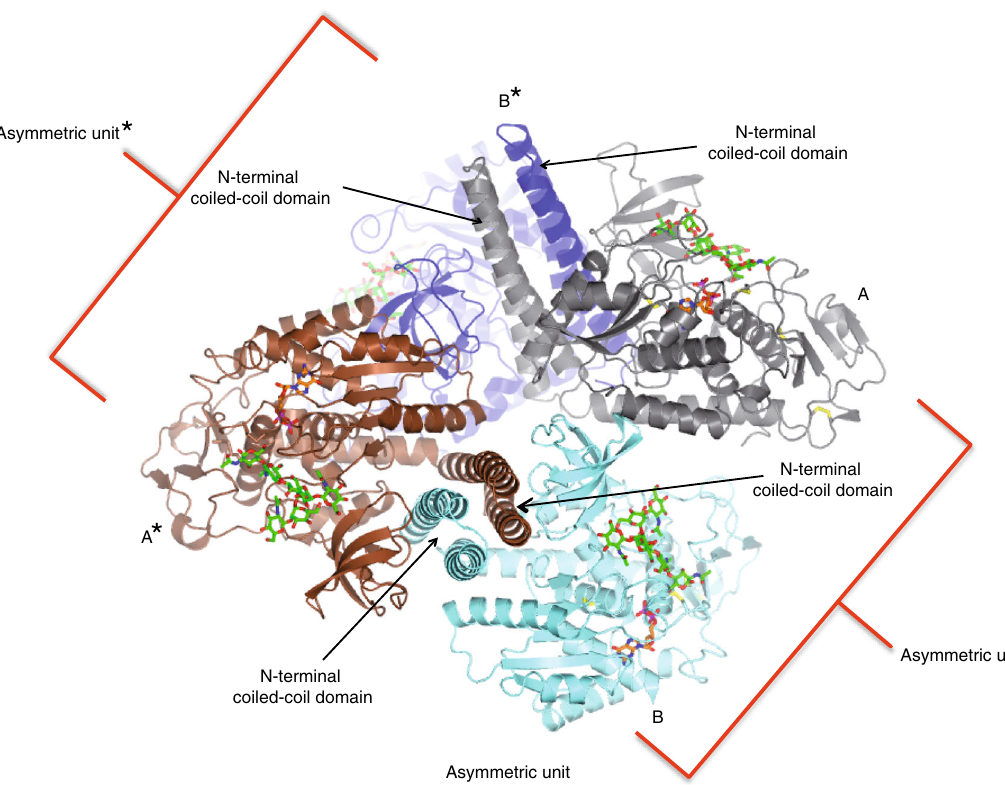
Fig. 3 Dimeric structure of Hs FUT8. One Hs FUT8 molecule (A in gray) from one asymmetric unit forms a dimeric structure with another molecule (B* in blue) from the other asymmetric unit* through their corresponding coiled-coil